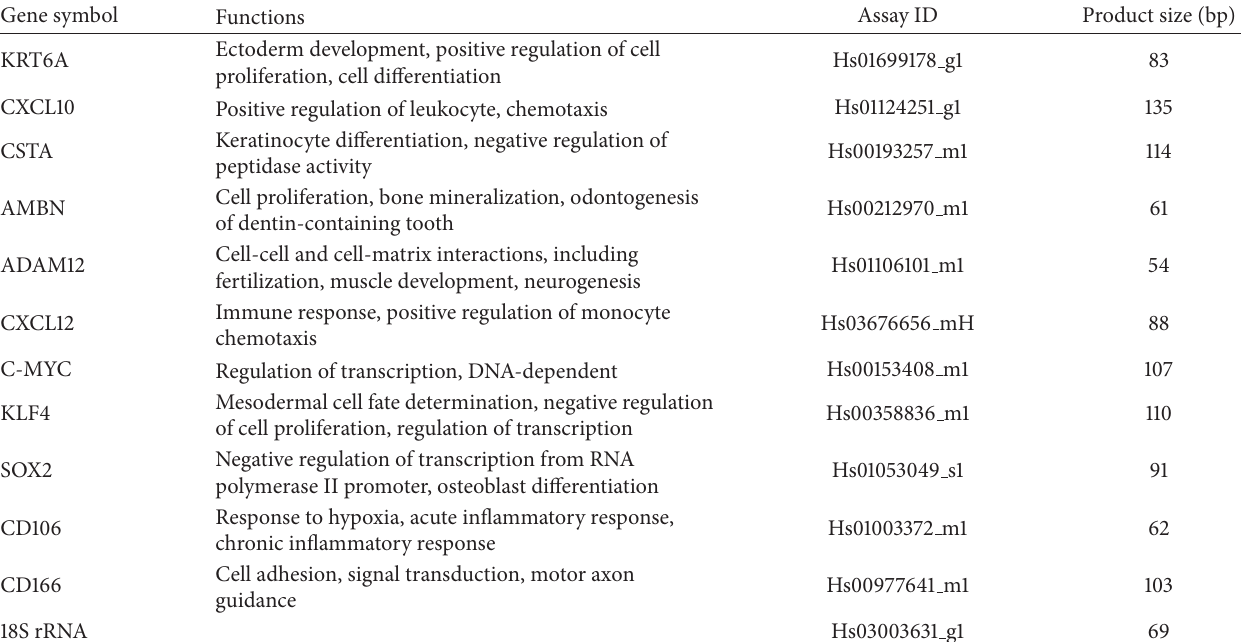
Table 1: Specific primer used for quantitative RT-PCR